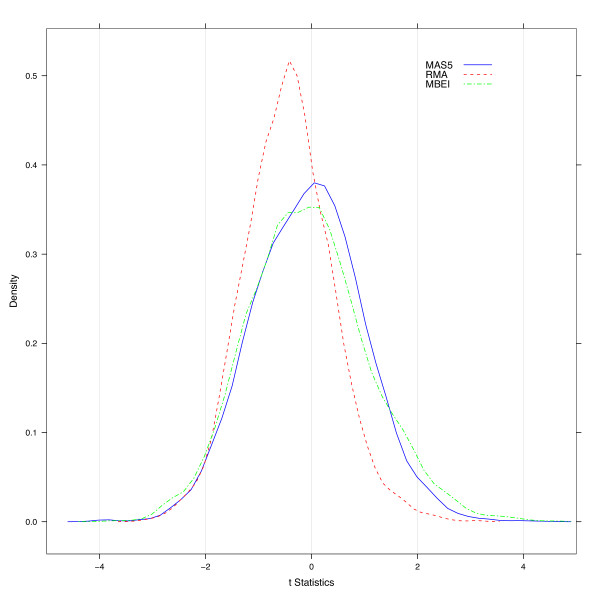
Distributions of t-statistics calculated from different expression measures for genes that are completely absent in the Breast Cancer data. The same default normalization procedures as in Figure 2 were applied. The t-statistics compare expression values between users and non-users of hormone replacement therapy (HRT) in the sample as in Figure 4. The density curves show the smoothed histograms of the test statistics for 4371 probe sets that had absent calls on all 159 chips. The MAS5 curve is centered at zero and close to a standard normal distribution expected approximately if no gene is differentially expressed between HRT users and non-users. The RMA curve is strongly shifted to the left, indicating wide-spread down-regulation of numerous absent genes in non-users; the MBEI curve shows moderate asymmetry and heavy tails at both sides, indicating more moderate, but still common gene regulation. Given the low signal quality of these genes that were classified as absent throughout the data set, small or no detectable regulation effects seem biologically most plausible.